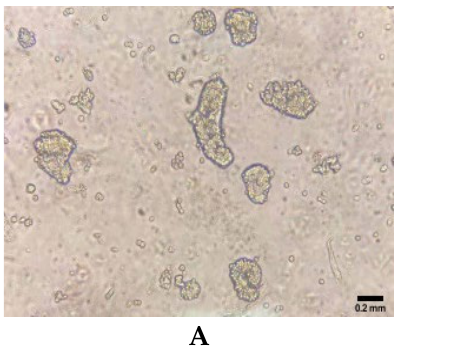
Figure 1. Morphology of primary duck intestinal epithelial cells isolated from duck embryos. ( A ) Cellular morphology in 6 h in culture after isolation. ( B ) Cellular morphology at passage 3 in culture.